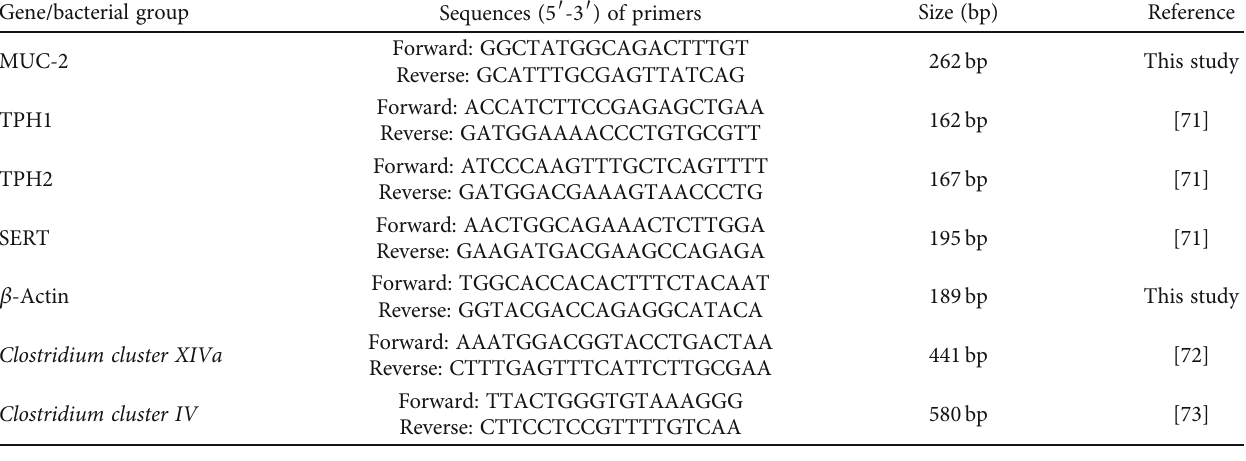
Table 1: List of PCR primers used for qPCR detection of gene expression and bacterial groups.